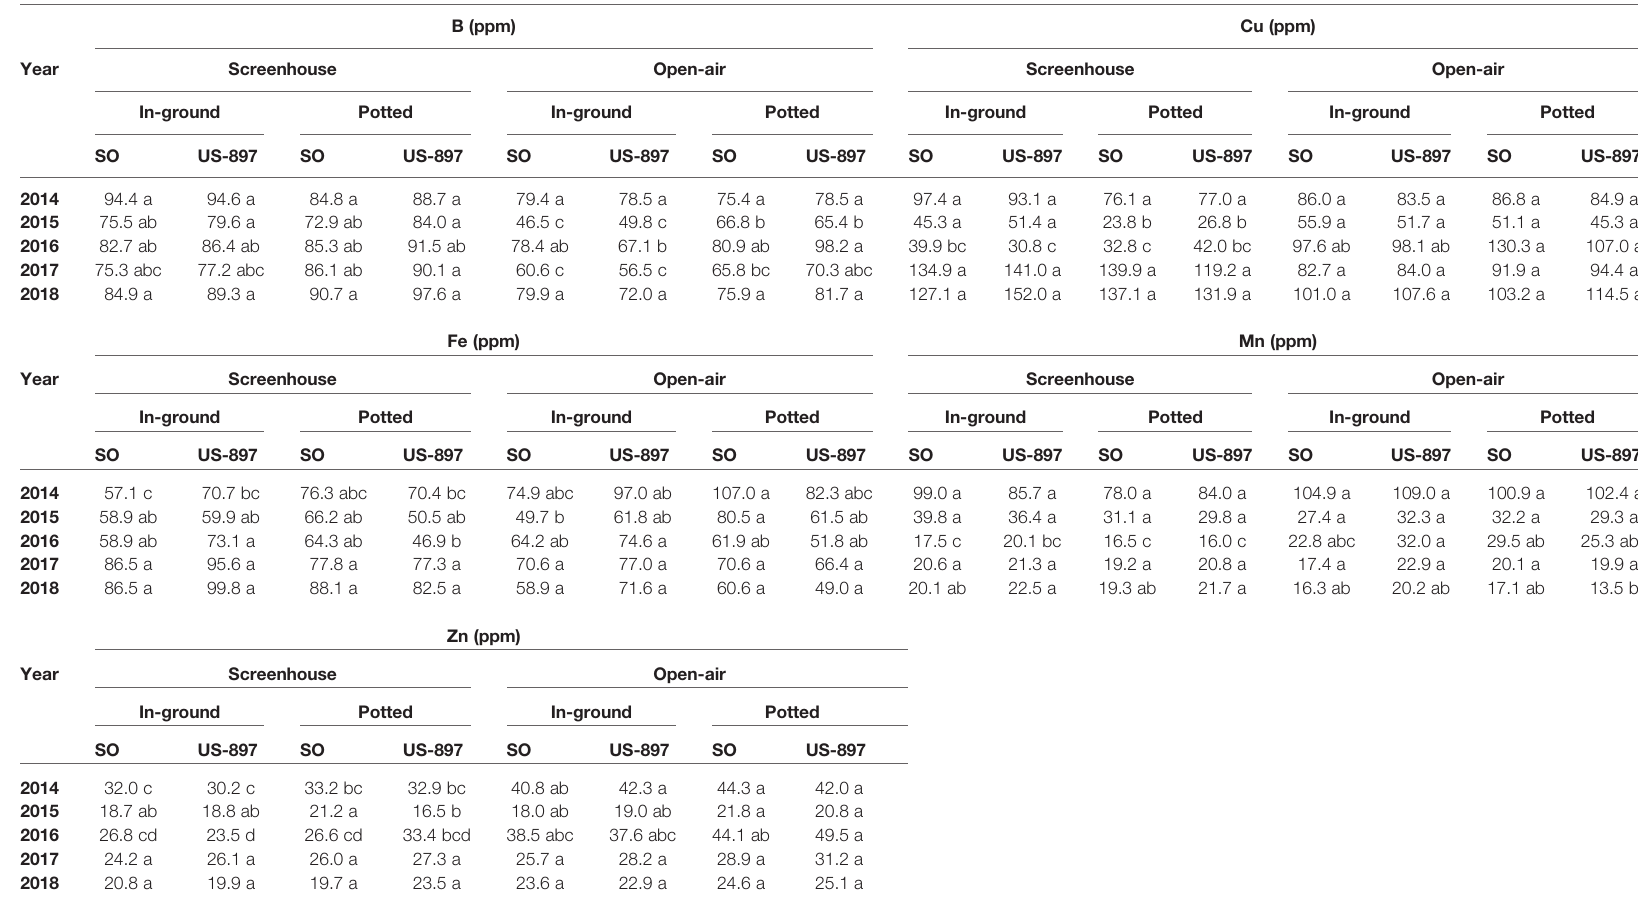
Mean ± standard error of four replications. Means with the same letter are not signi fi cantly different from each other at 5% probability (P ≤ 0.05) using Tukey mean comparison